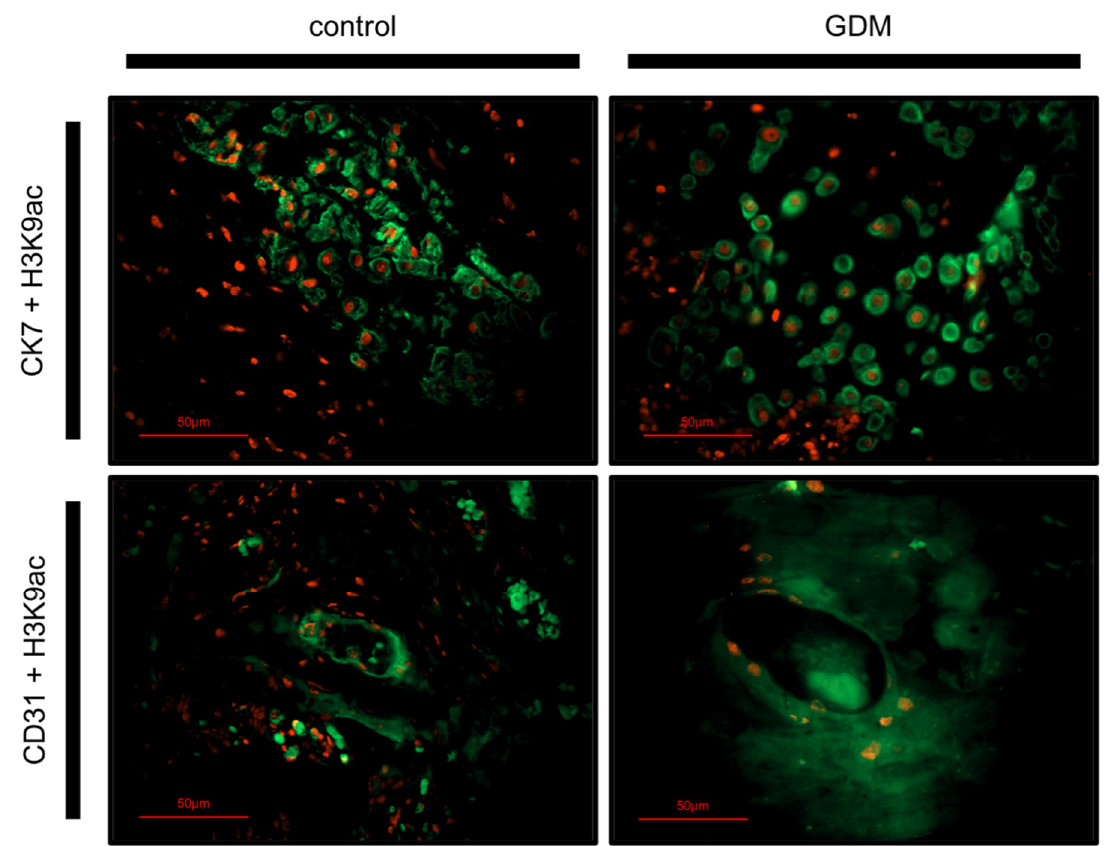
Figure 2. Double immunofluorescence phenotyping of placenta cells. H3K9ac, marked with Cy-3-labled secondary antibody, is stained red in both rows. CK7 is stained green in the first row, marking EVT cells. CD31 is stained green in the second row, marking endothelial cells. Pictures were taken with a 400× lens.